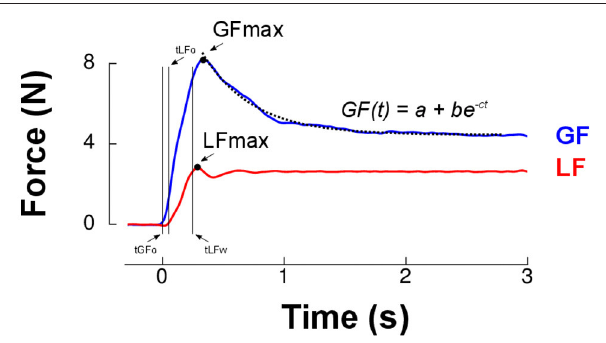
FIGURE 2 | Grip force (blue trace) and load force (red trace) over time for a single lift trial. The first two vertical cursors (tGFo and tLFo) enclose the preload phase. Time 0ms corresponds to grip force onset (tGFo). The loading phase is the time between tLFo and tLFw (two last vertical cursors, see Methods). The dashed line is the best exponential fit to grip force between its peak (GFmax, black dot) and the end of the trial. Parameter a provides a more reliable estimate of grip force reached in the plateau phase than a classical average during the last portion of the trial. The rate of decrease of grip force following its maximum was quantified by parameter c.